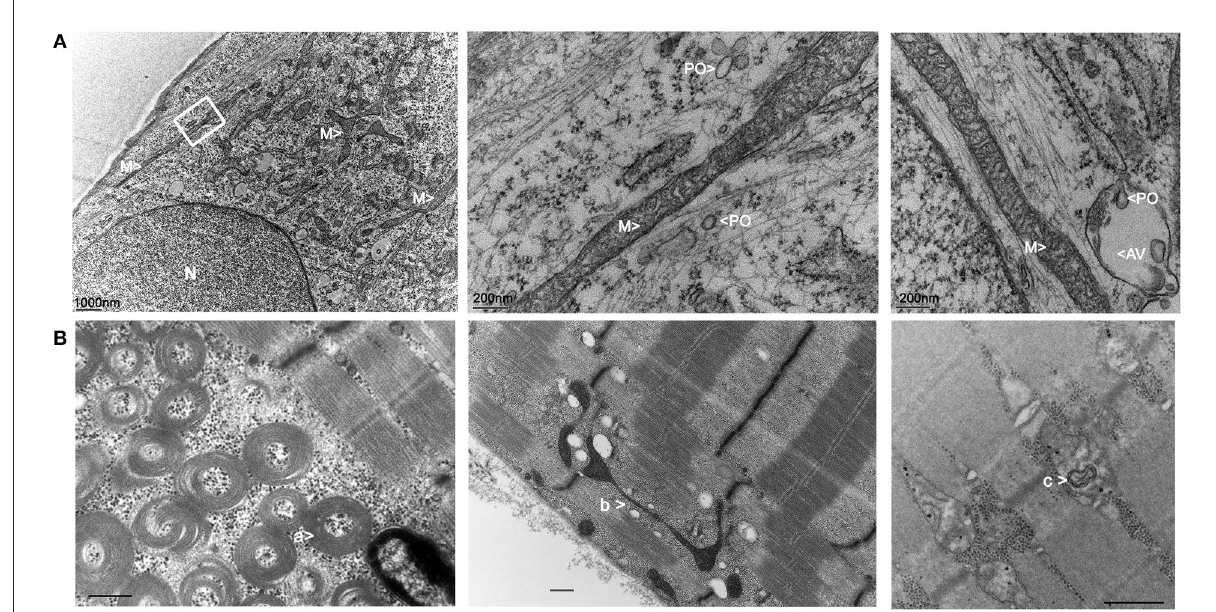
FIGURE3 Electron microscopy imaging of the patient fibroblasts and muscle. (A) Skin fibroblasts: M, mitochondria; PO, peroxisomes; N, nucleus; AV, autophagic vacuole. (B) Muscle biopsy: a: concentric laminated bodies; b: mitochondrial nano-tunnel; c multiple degenerative myelinoid intramitochondrial